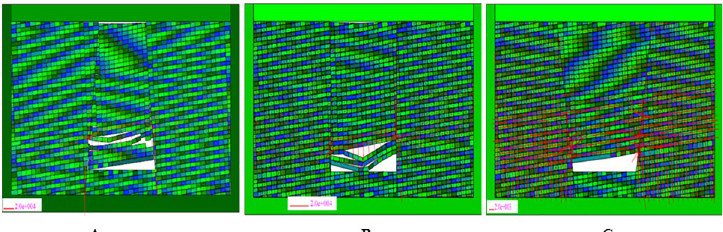
Fig 18. The final principal stress of different collapse columns. (A) Inverted funnel. (B) Columnar. (C)